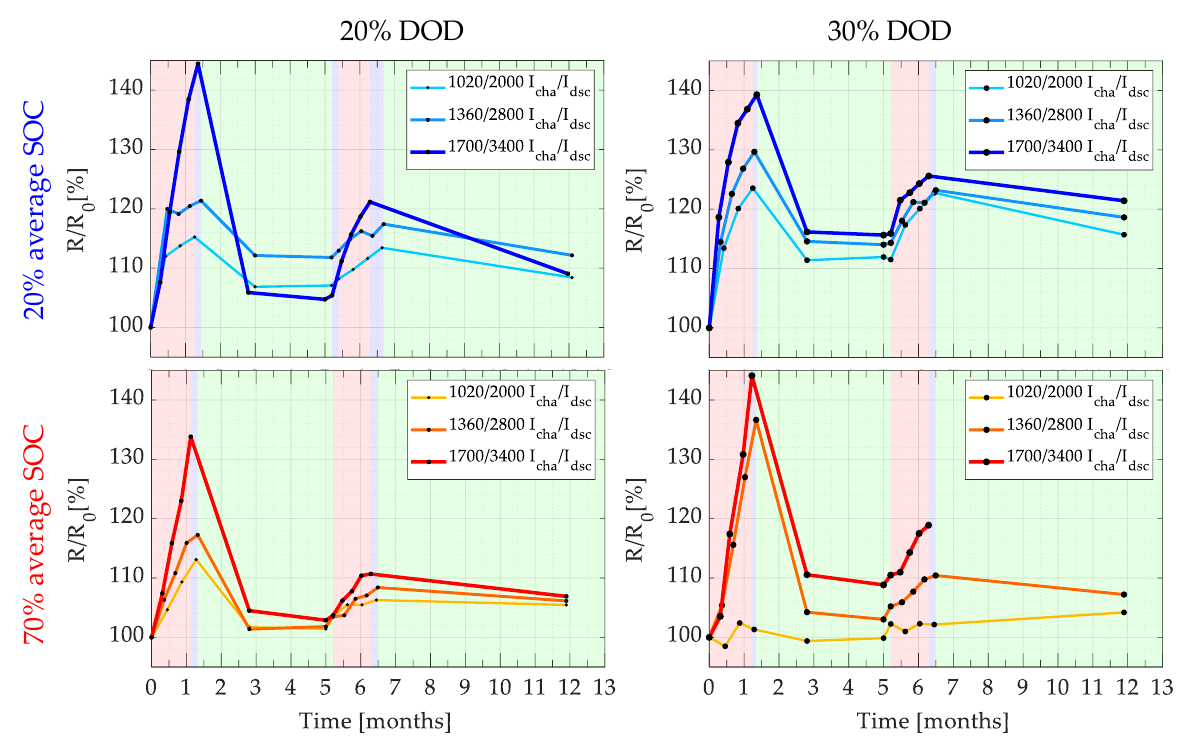
Figure 5. Pulse resistance for cells cycled with charge/discharge currents in mA of 1020/2000, 1360/2800, and 1700/3400. The plots are arranged in a matrix with the average SOCs of 20% and 70% and DODs of 20% and 70%. Cycling, transition, and resting phases are depicted with red, blue, and green backgrounds,